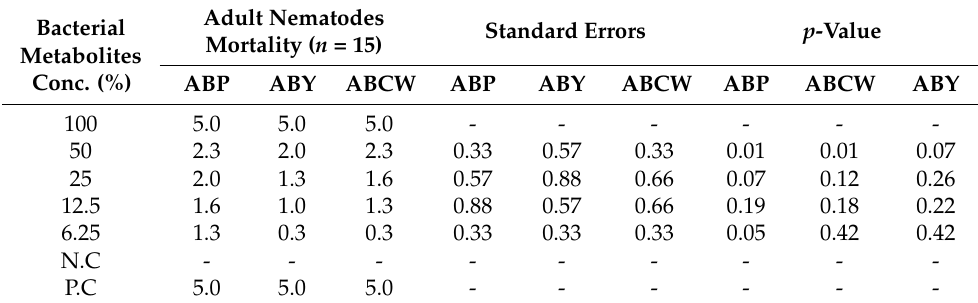
Table 5. Adult nematodes mortality by metabolite concentrations of the bacterial isolates.